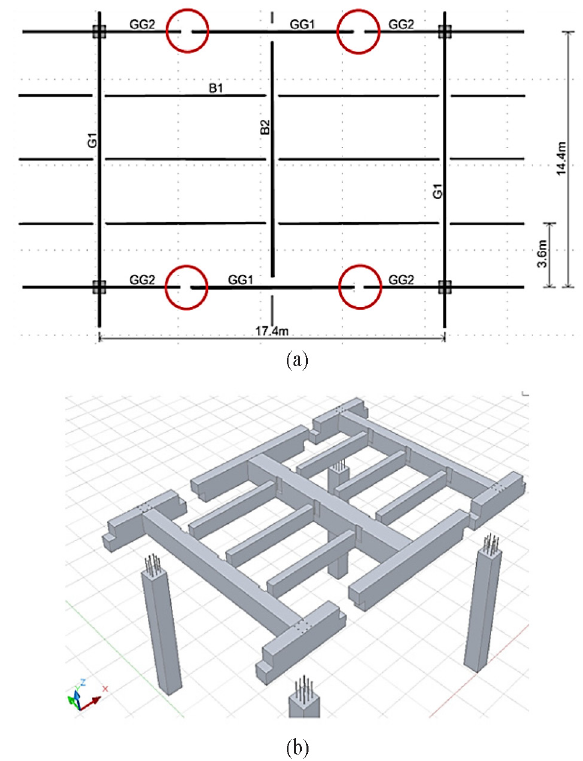
Fig. 2. An example of a segmented PC beam system